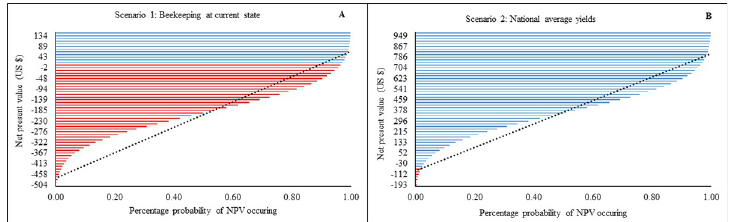
Fig 3. Probability (%) changes in Net Present Value (NPV) for changing current situation (Scenario 1) to obtain national average yields (Scenario 2). Red lines indicate loss and blue lines profit. Dotted black line is a linear forecast. NPVs to the right of the line indicate optimal profit/loss attained for each an intervention level.